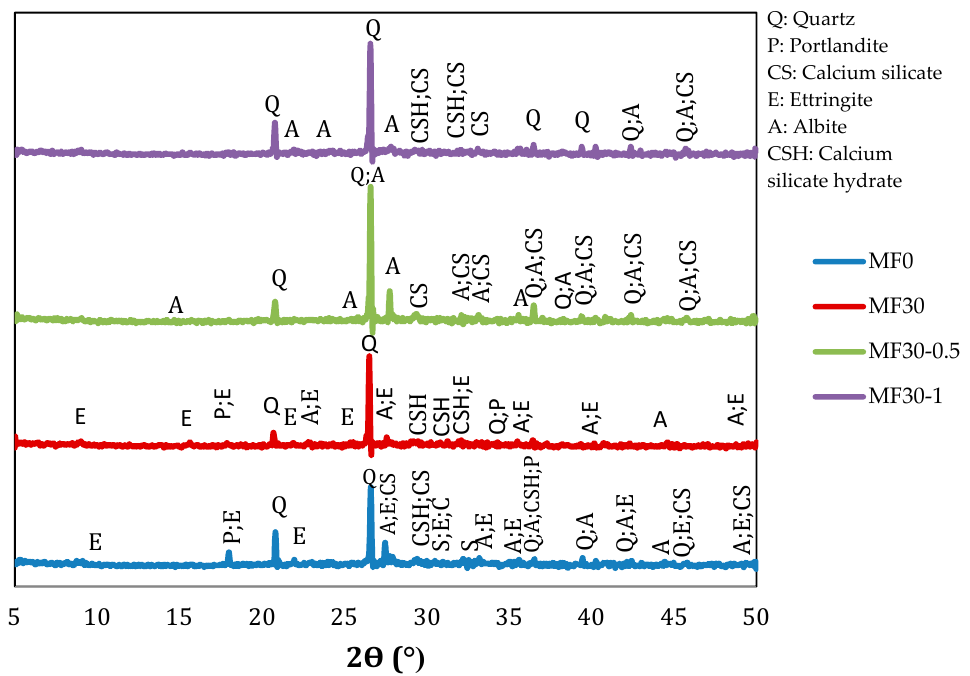
Figure 11. XRD of concrete mixtures (MF0, MF30, MF30-0.5, and MF30-1). Table 4. XRD diffraction peaks.